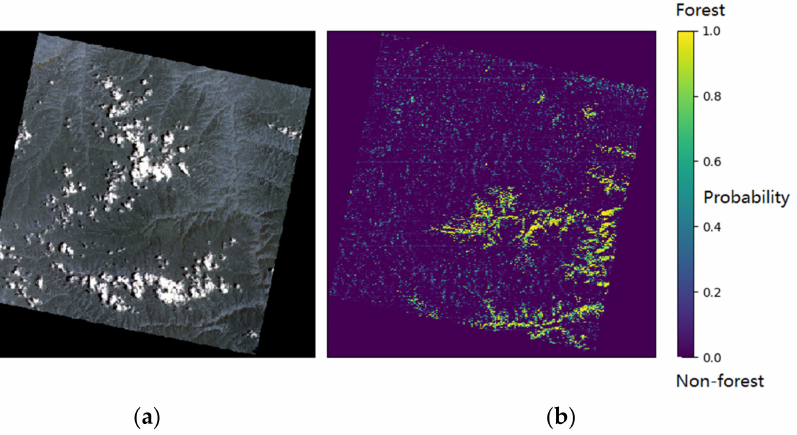
Figure 17. Visualization of a ZY-3 satellite imagery for Western part of Sanjiangyuan National Nature Reserve, at 12 May 2017: ( a ) false color composite images; ( b ) the plateau forest segmentation based on the proposed method.